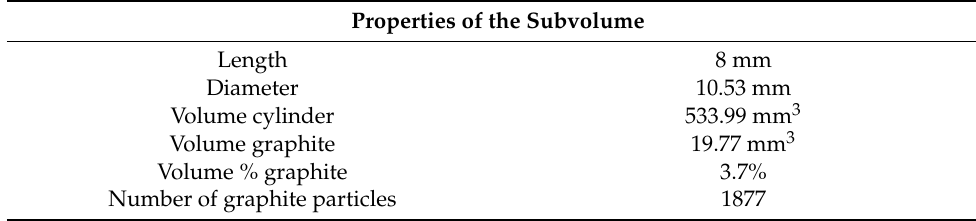
Table 4. Segmentation and analysis results of the sample.